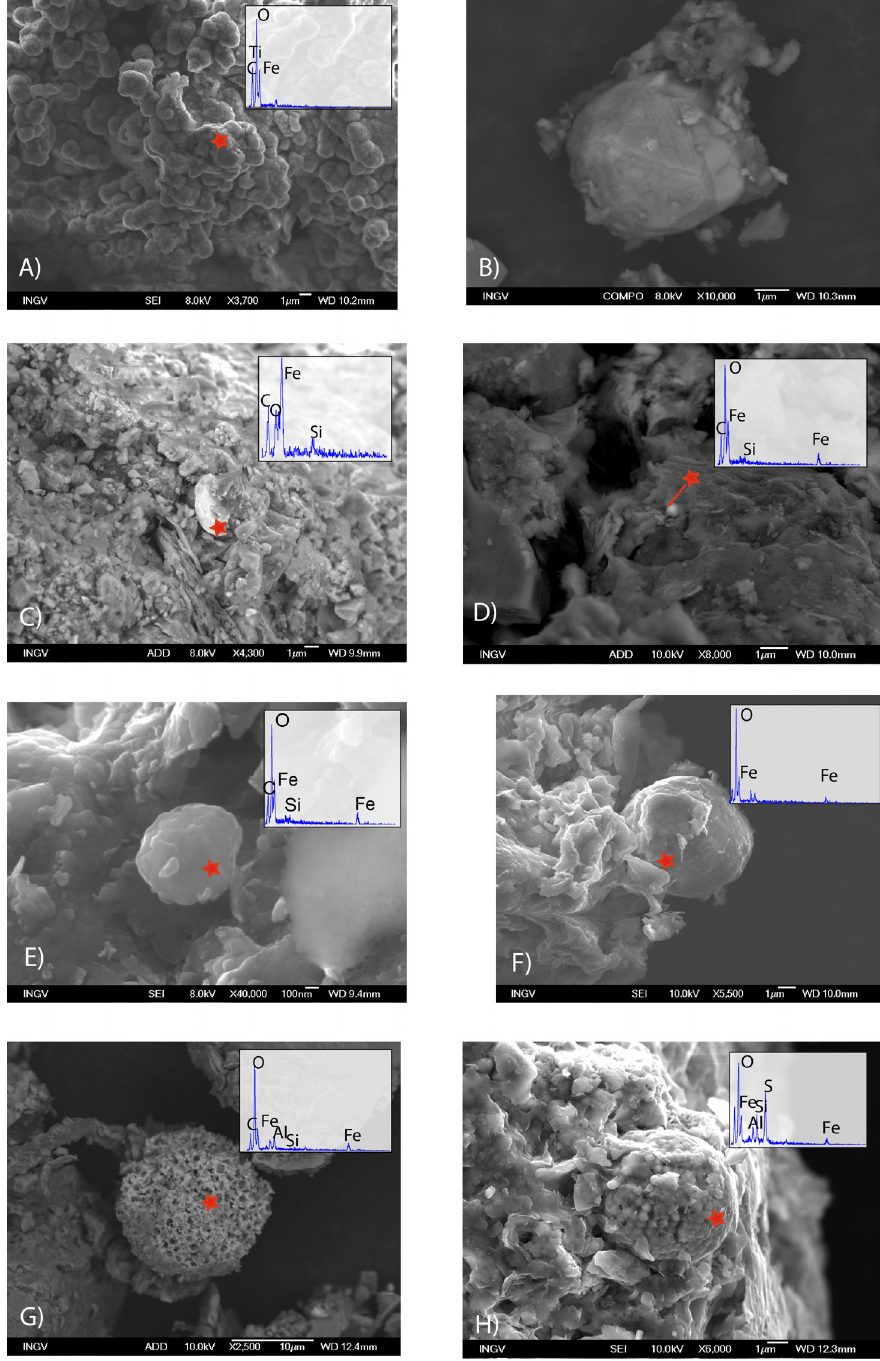
Figure 8. Morphological analysis and chemical composition of selected sample. (A) Road dusts Fe-Oxides aggregates as comparison (per- sonal communication L. Alfonsi); (B) natural Ti-reach magnetite, in the images SS17 sample; (C) lamellae shaped Fe-oxides, sample SS17-1; (D) Nanometre Fe-Oxides spherule from SS39-5; (E) orange peel shaped Fe-oxides at sample SS50-2; (F) orange peel Fe-oxides sample SS87- 4; (G) Fe-Oxides aggregates, SS94-5; (H) framboid shaped sulphide, SS94-40. The numbers aside the site abbreviation indicate the distance from the road border; red stars indicate the position of chemical composition